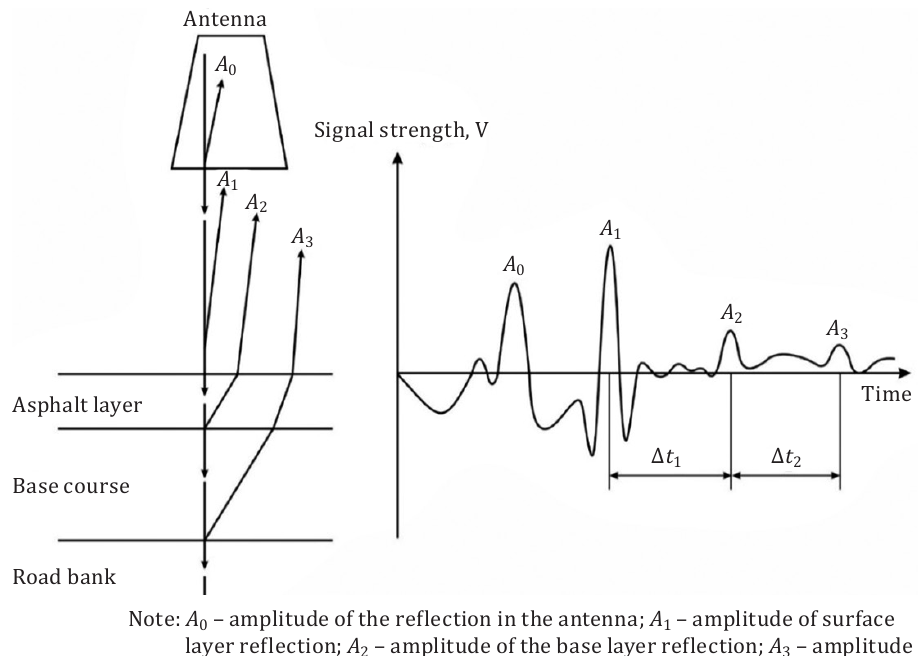
Figure 2. Operation diagram of air-coupled antenna of Ground